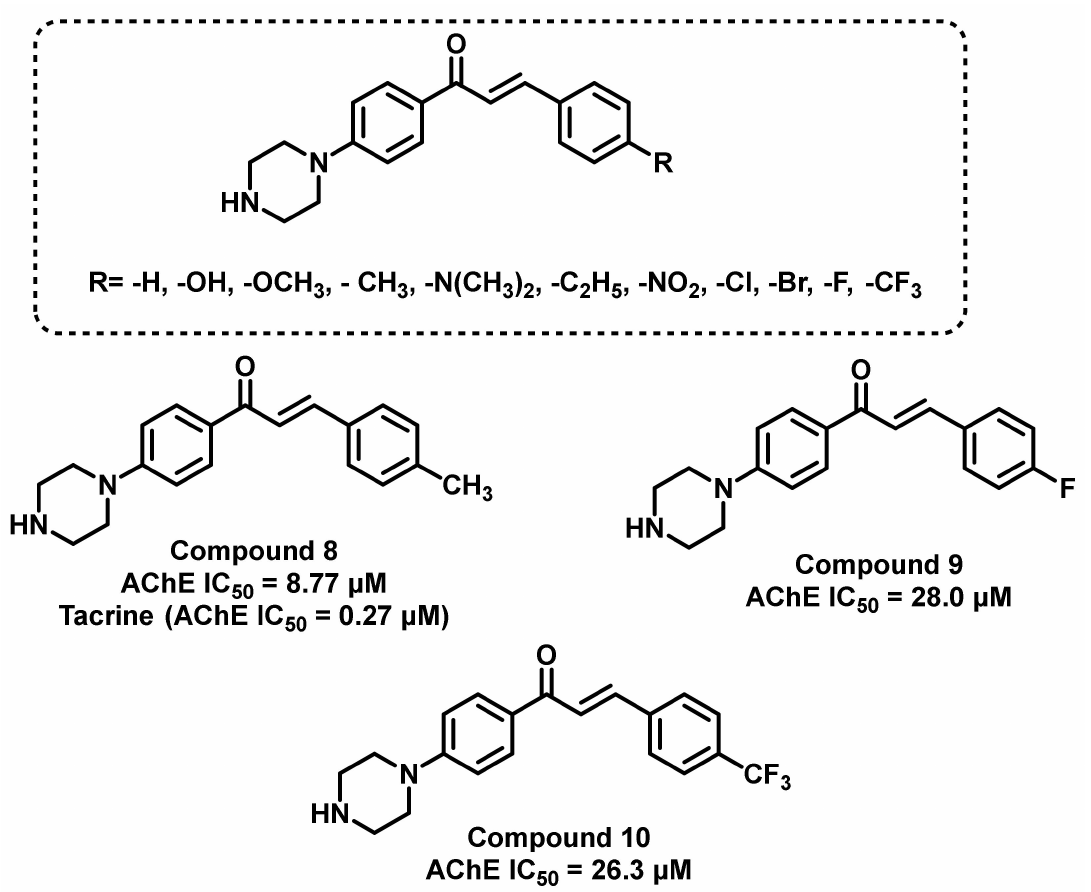
Figure 13. Structural refinement involved the modification of simple amino to cyclic piperazine derivatives.